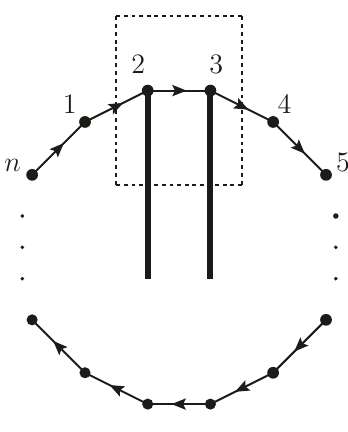
( i 1 ; (cid:1) (cid:1) (cid:1) ; i n ). n